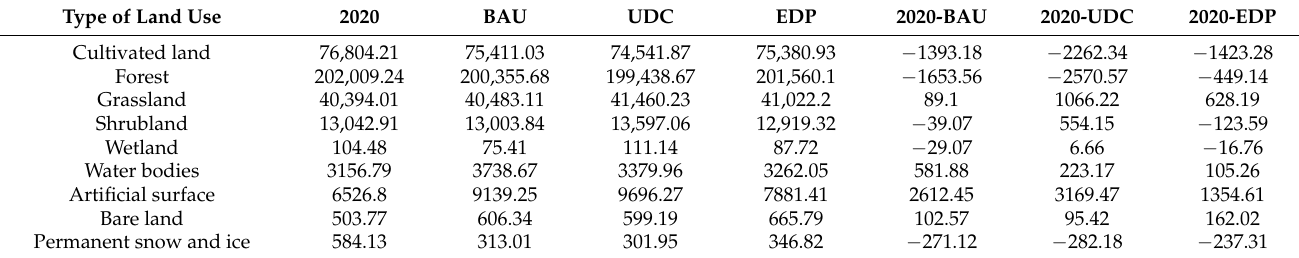
Table 4. Projected land area in 2030 for the three scenarios and the area of change compared to 2020 (km 2 ). Type of Land